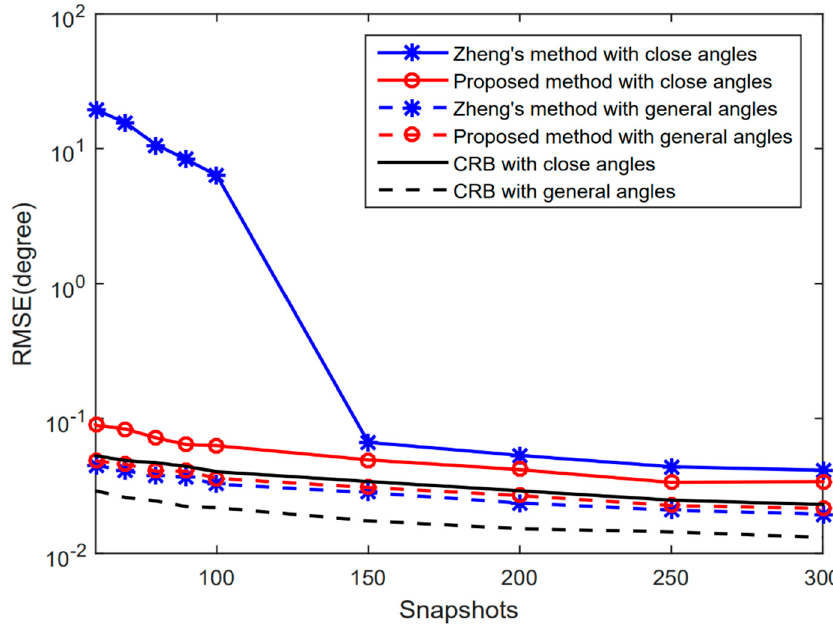
Figure 3. RMSE performance versus snapshots number.